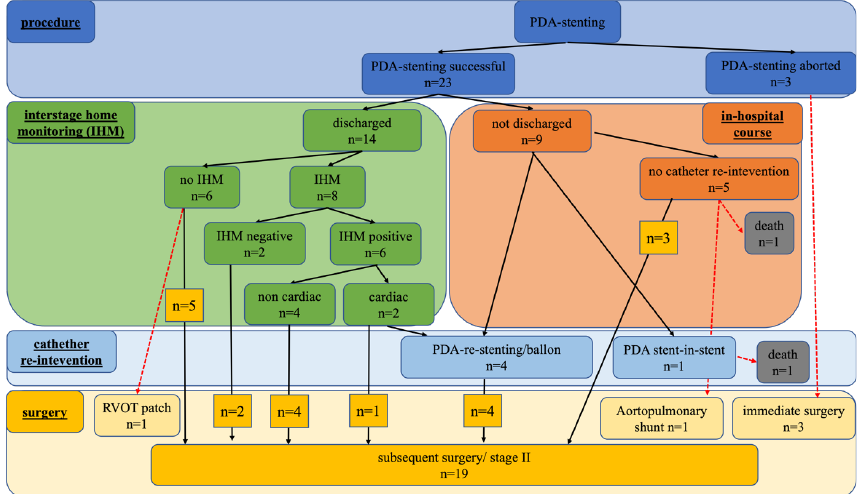
Figure 1. Clinical course during interstage home monitoring (IHM) (highlighted in green) or in hospital (highlighted in orange) after neonatal PDA-stenting in the duct-dependent complex type of CHD with uneventful course or with the need for emergent surgical procedures (highlighted with red arrows) or catheter re-interventions (highlighted in light blue) up to the study endpoint with the subsequent surgical procedure—stage II (highlighted in yellow). Table 2. Comparison of discharged and non-discharged infants after PDA-stenting during short- to mid-term follow-up until subsequent surgical procedure.